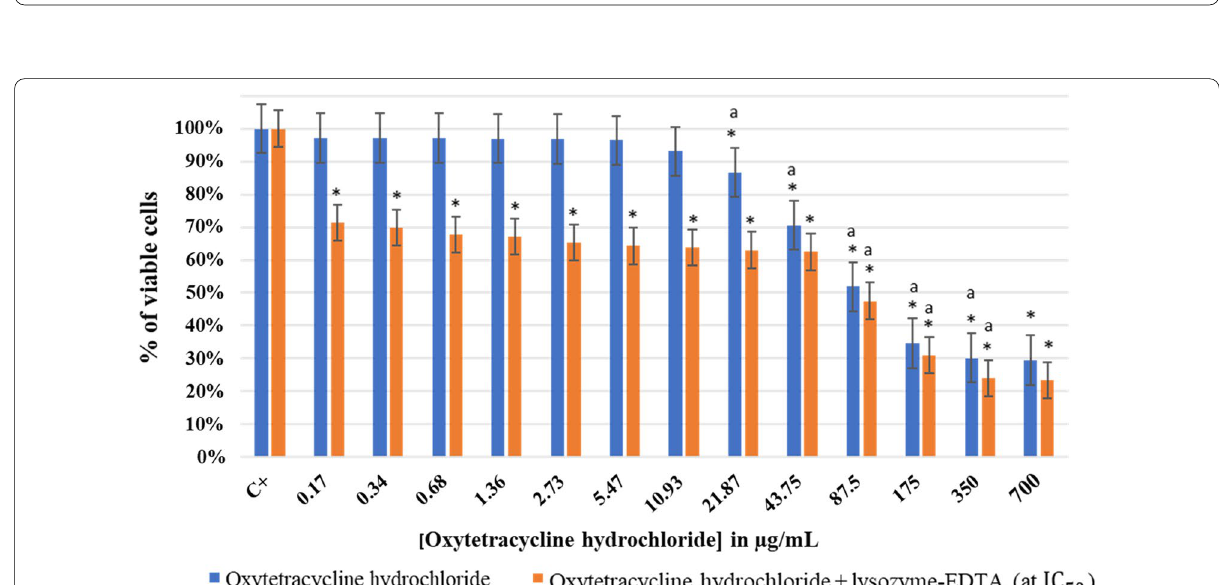
Fig. 4 Effect of oxytetracycline hydrochloride with and without lysozyme-EDTA (at IC 50 ) on planktonic Lactobacillus rhamnosus GG at pH 7.5. OD 600 of negative control (oxytetracycline hydrochloride) 0.32, OD 600 of 700 μg/mL of oxytetracycline hydrochloride with lysozyme-EDTA (at = IC 50 ) 0.38. The results are mean values of three replicates. (*) indicates a significant difference (P < 0.05) between each test and the positive control = (oxytetracycline hydrochloride). The lowercase letter a indicates a significant difference (P < 0.05) between each test and its preceding. Error bars represent the SD (standard